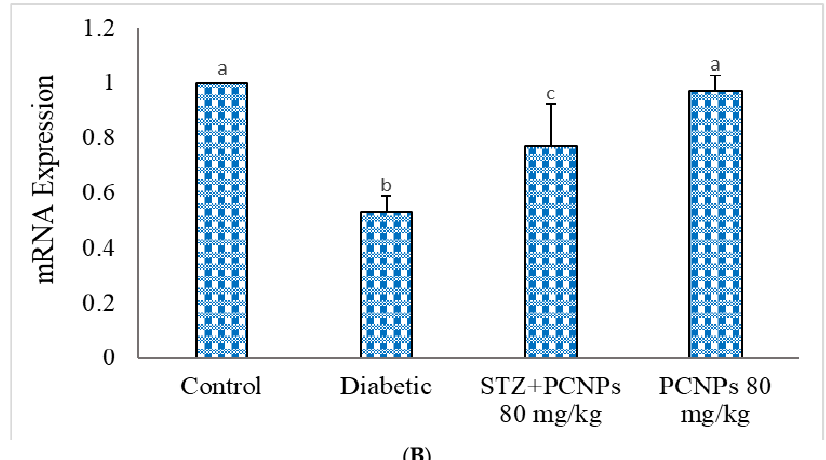
Figure 13. ( A ) Expression of KIM-1 mRNA in renal tissues of experimental and normal rats. PCNPs inhibit the expression of KIM-1 in DN rats. Values are means ± SD for six rats at p < 0.05 (DMRT). a PCNPs alone treated group compared with control group. b Diabetic group compared with control group. c Treatment group compared with diabetic control. ( B ) Expression of GLUT-2 mRNA in pancreatic tissues of experimental and normal rats. PCNPs inhibit the expression of GLUT-2 in DN rats. Values are means ± SD for six rats at p < 0.05 (DMRT). a PCNPs alone treated group compared